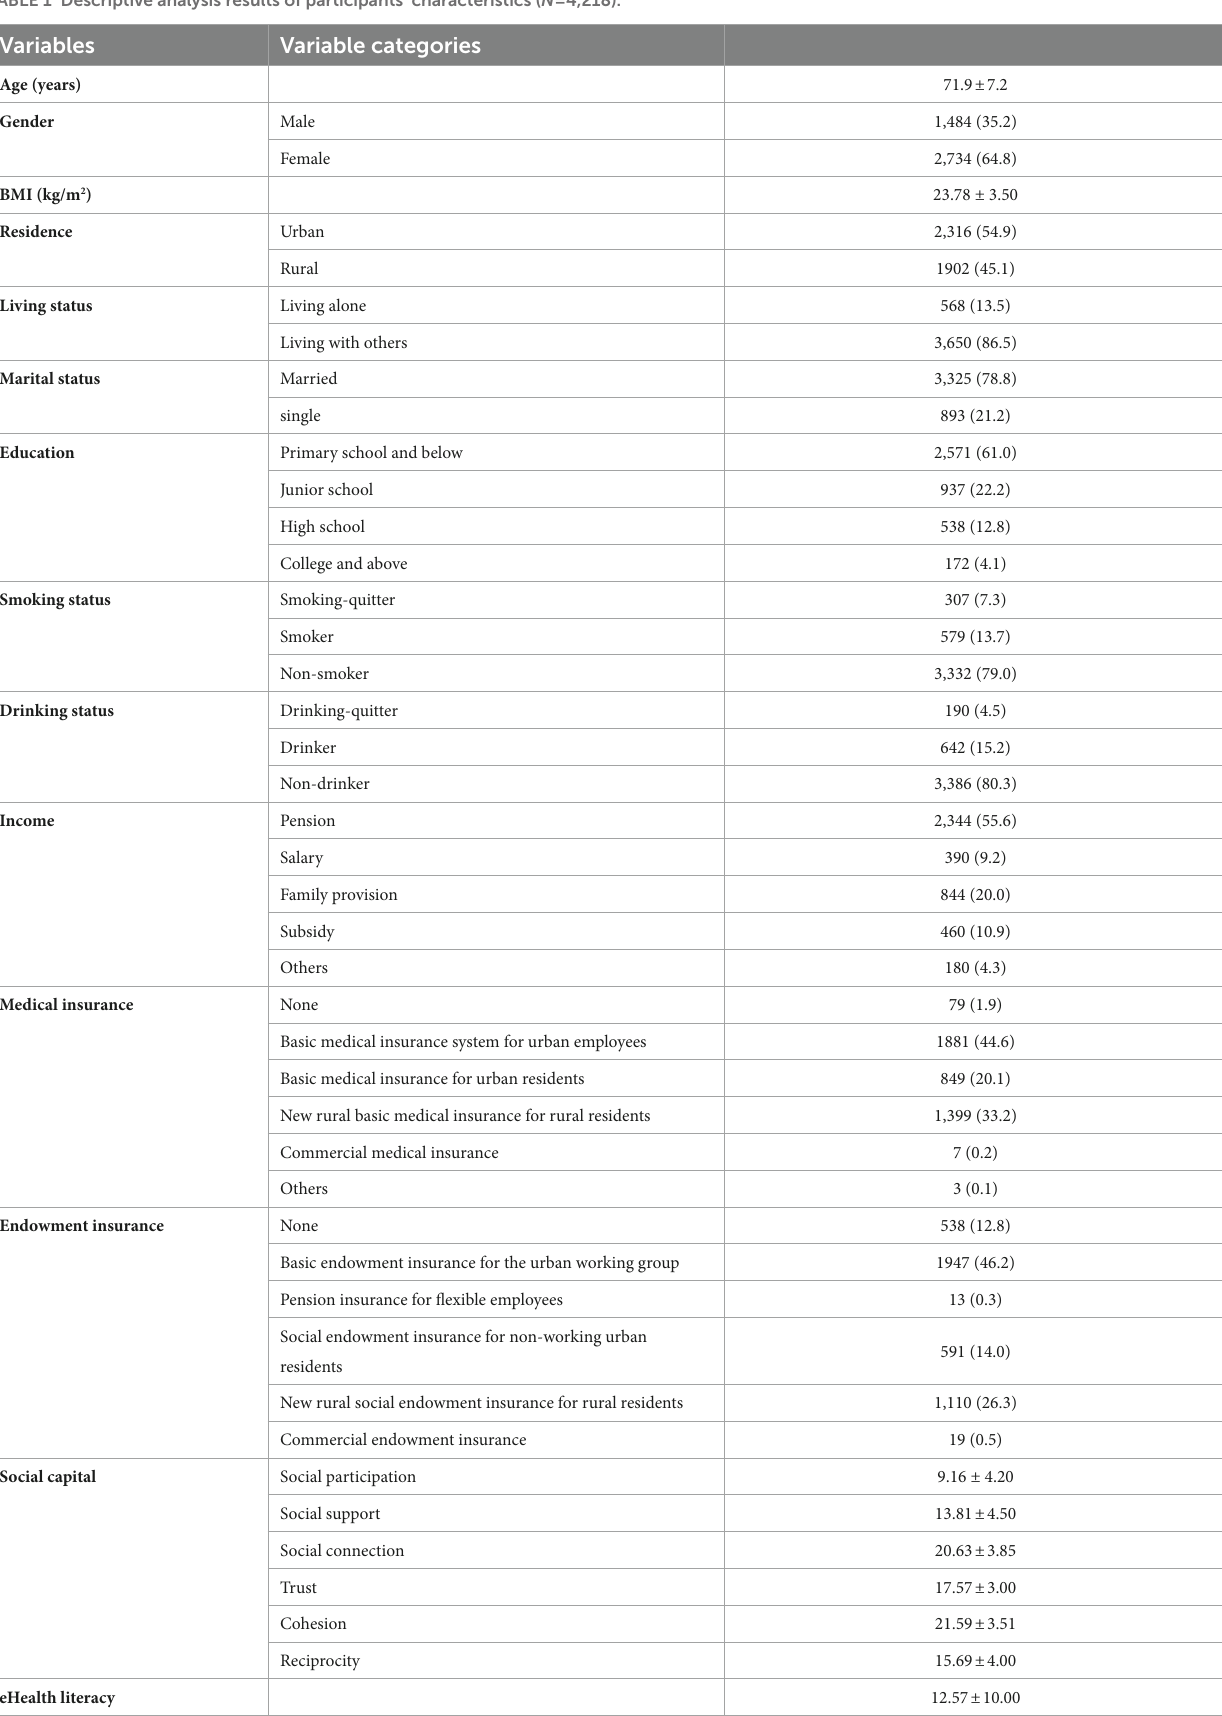
TABLE 1 Descriptive analysis results of participants’ characteristics ( N =